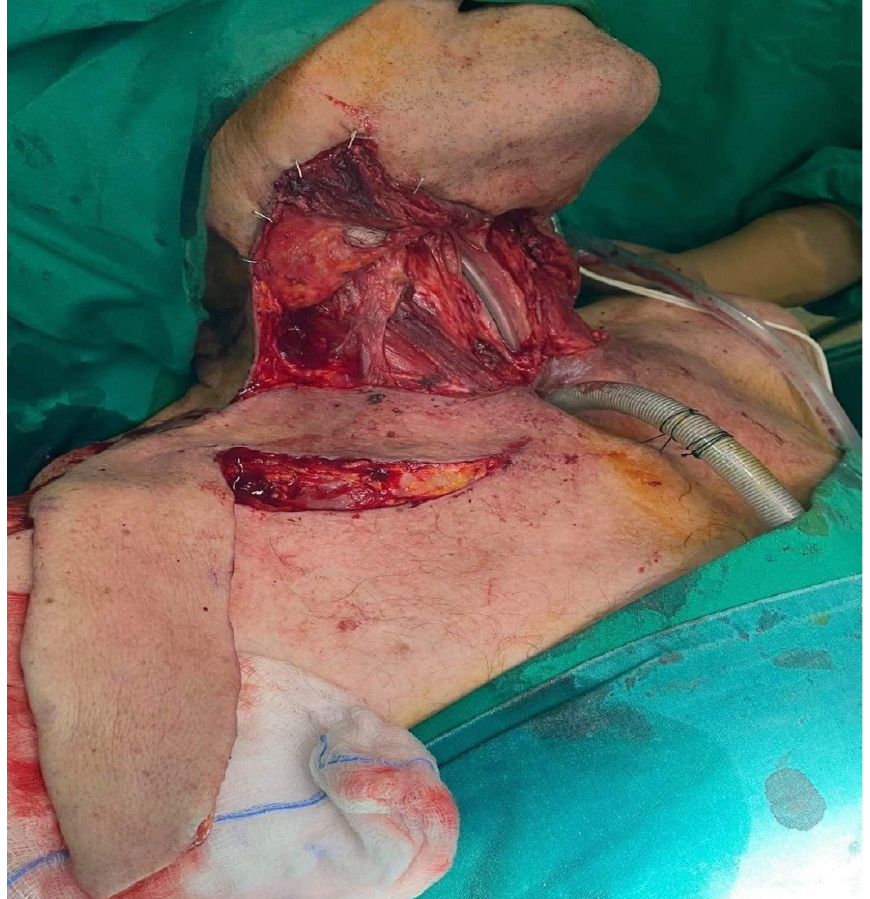
Figure 1. Intraoperative view of the defect and the supraclavicular flap raise.